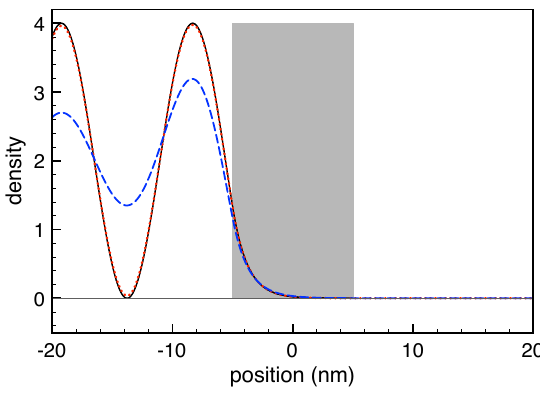
Figure 10. The same as in Figure 8 but replacing the semiclassical IBC scheme based on the local RTA model in Equation (7) with the fully non-local model in Equation (32). To this end, the monoenergetic left injection of the IBC scheme employed in Figure 8 is replaced by a thermal coupling of the device with a corresponding monoenergetic distribution in the left reservoir via a relaxation time 1/ Γ res The coherent-limit result (solid curve) and the weak-dissipation one (dashed curve) are basically coincident; the dash-dotted curve refers to the strong-dissipation